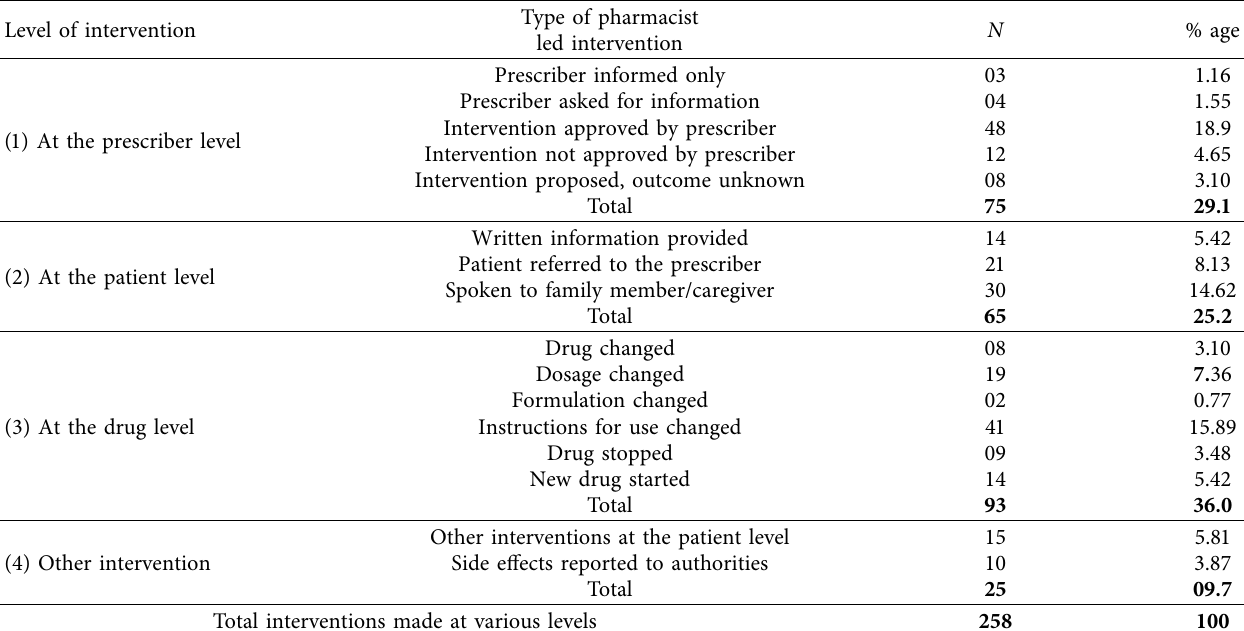
Table 4: Pharmacist-led interventions at various levels during the study period.